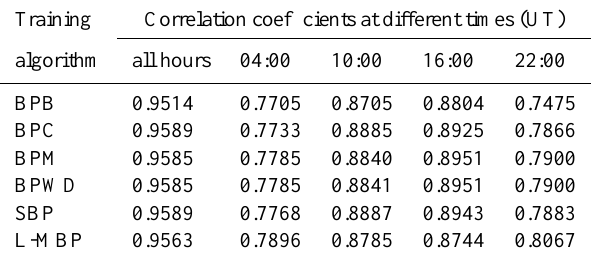
Table 3. Computed correlation coefficient values for CPTN in